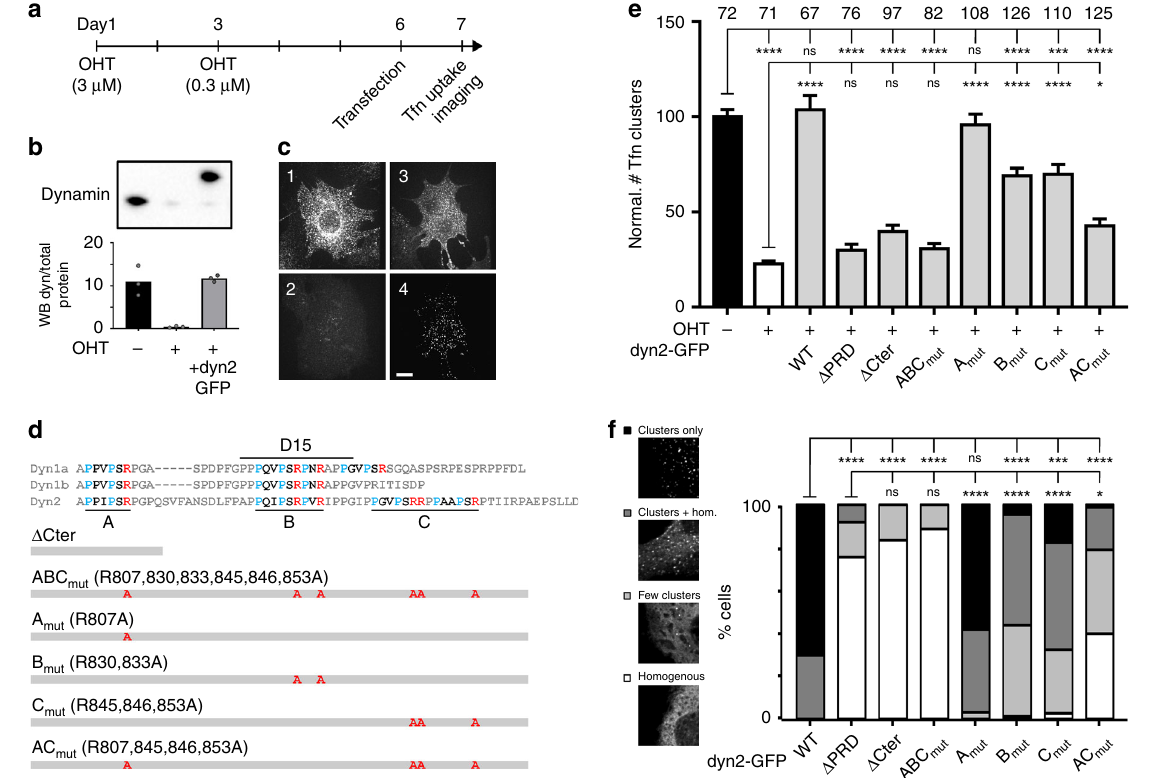
Fig. 1 Rescue of endocytosis in dynamin TKO cells with PRD mutant dynamins. a Protocol for dynamin knock-out and rescue. After 6 days of gene excision of the three dynamin genes following hydroxytamoxifen (OHT) treatment, cells are transfected with electroporation. Tfn uptake and imaging assays are performed the next day. b Western blot with pan-dynamin antibody on untreated cells, cells treated with OHT or cells treated with OHT and transfected with dynamin2-GFP. Note the migration at higher molecular weight of dyn2-GFP. Bottom, quanti fi cation in three experiments of the WB signal normalized to the total amount of protein. See Supplementary Fig. 1A for full gels and blots. c Example images (red channel) of cells incubated with Tfn-A458 for fi ve minutes, washed and fi xed. (1) Not treated with OHT, (2) treated with OHT, (3) treated with OHT and transfected with dyn2-GFP. (4) GFP channel of the cell shown in (3). Scale bar 10 µ m. d Sequences of the C terminal parts of the PRD of dyn1 (a and b splice variants) and dyn2, with the class-II SH3 binding motifs A, B and C indicated. Below, mutants of dyn2 used to rescue Tfn-A568 uptake with the corresponding mutations. e Quanti fi cation of Tfn-A568 uptake, expressed as the density of detected clusters for cells treated with OHT and transfected with dyn2-GFP mutants as indicated. The number of cells imaged in four different experiments is indicated on top of each condition. The graphs show the average ± SEM for each dyn2 mutant. The adjusted p values of one-way ANOVA followed by Tukey ’ s multiple comparison tests are shown in Supplementary Table 3. f Quanti fi cation of dyn2-GFP localization in transfected TKO cells. Each cell was evaluated blind with a score ranging from homogenous labelling (white) to punctuate labelling without homogenous (black), with intermediates (mostly homogenous with few clusters, light grey; some homogenous with distinct clusters, dark grey). Examples in the left illustrate this scoring. Histograms show the proportion of each category of labelling. Stars indicate statistical signi fi cance (Kruskal – Wallis test followed by Dunn ’ s multiple comparison tests, p values in Supplementary